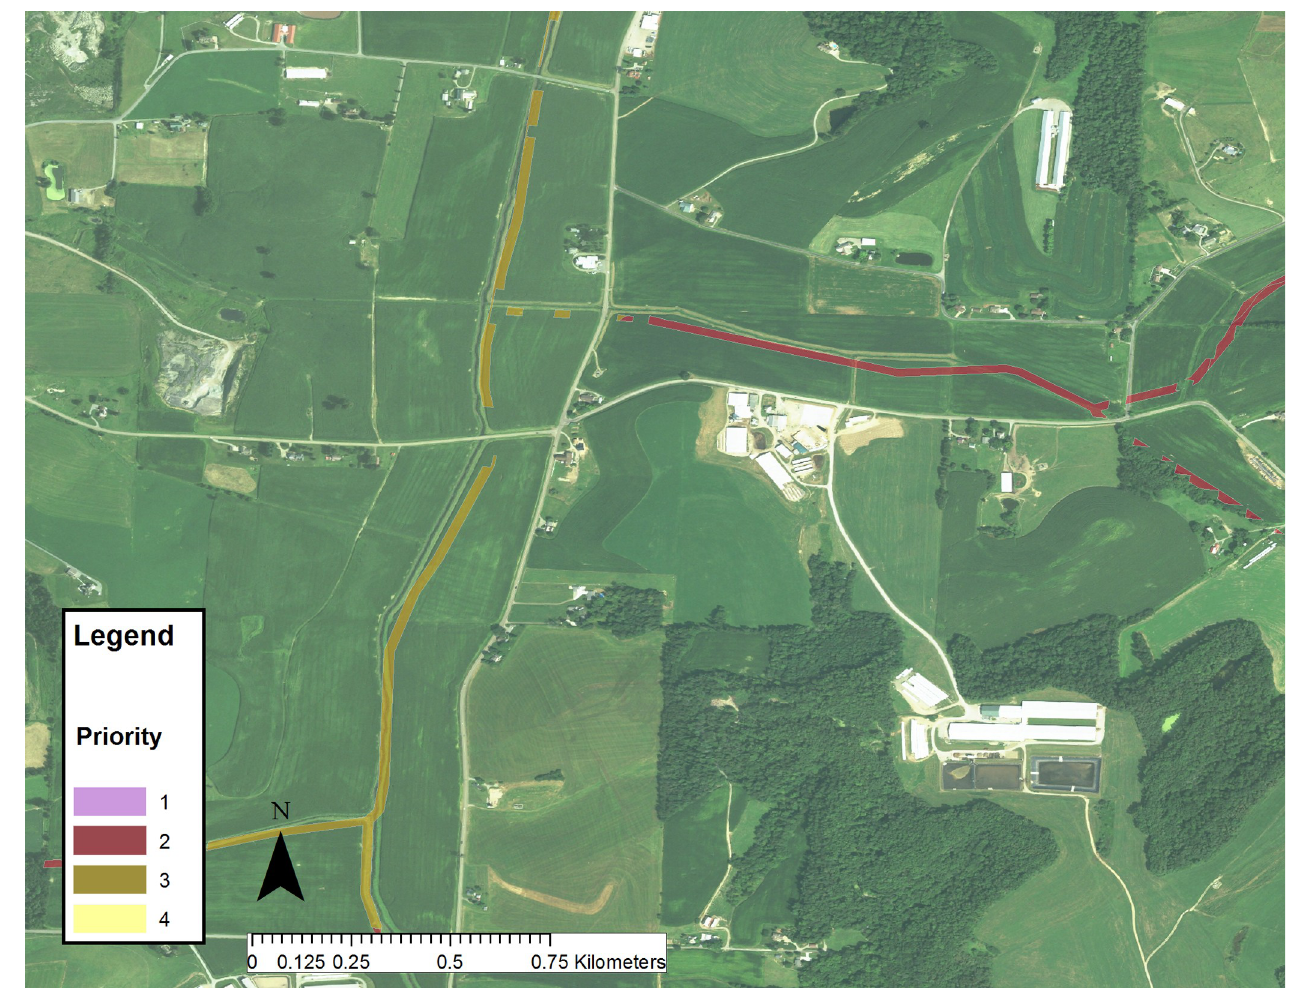
Fig 2. Priority analysis of buffer strips for croplands in a region of the Scioto River watershed. Color code is: highest = purple, high = red, medium = orange/brown, and low priority = yellow.